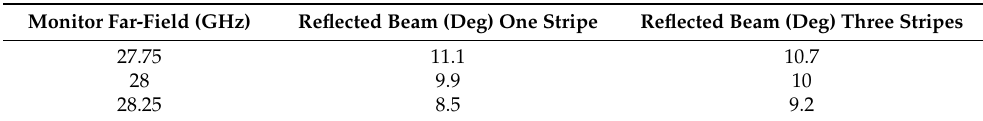
Table 4. Results of far-field radar cross section (RCS) for beam steering around 28 GHz for a uniform configuration compared to a three-stripe configuration.